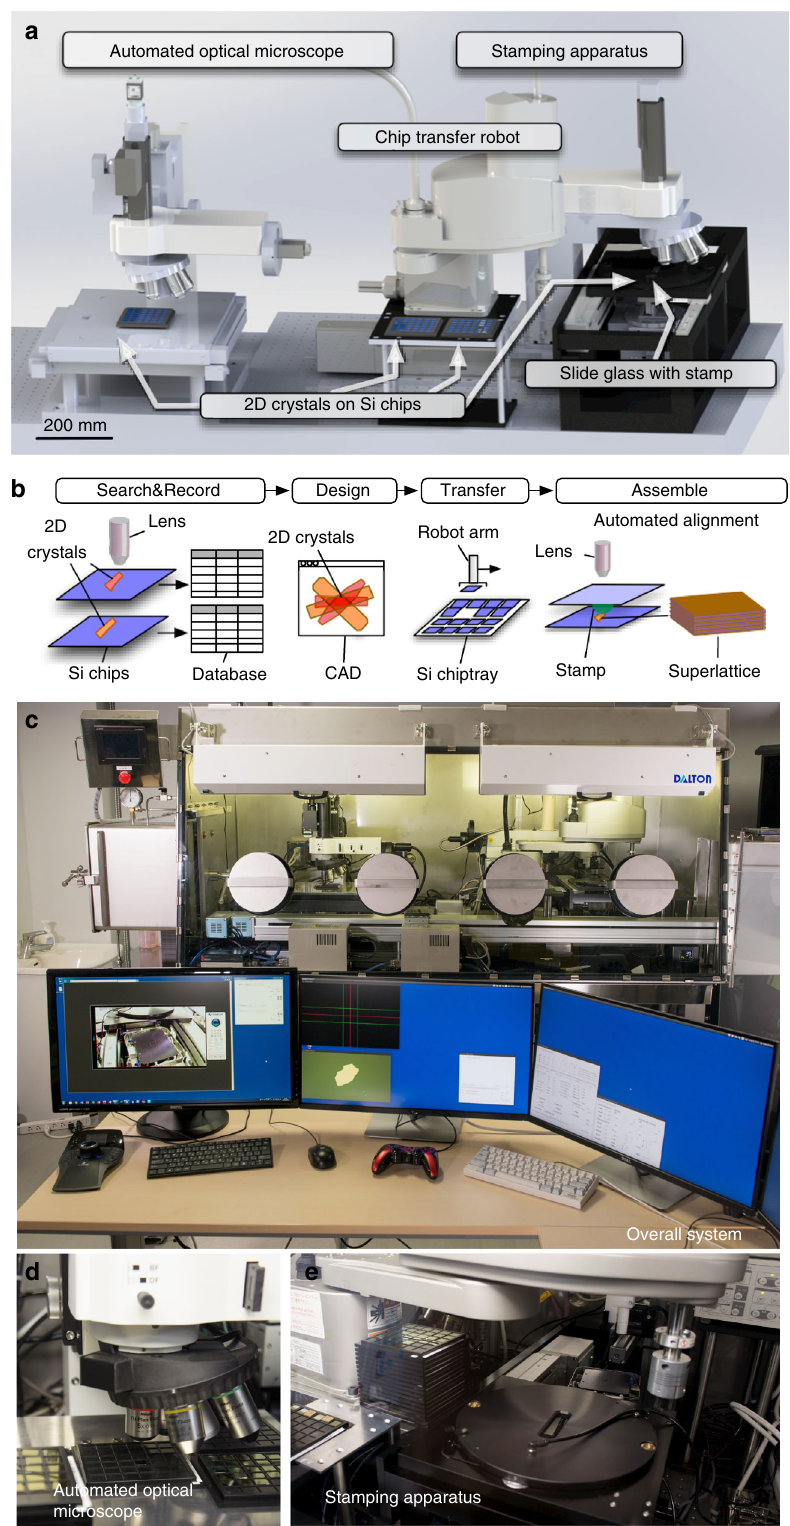
Fig. 1 The computer-assisted design schematics, functionalities, and photographs of the system. a Computer-assisted design schematics of the presented robotic system comprising an automated optical microscope, stamping apparatus, and Si chip transfer robot. b Schematics of the vdW heterostructure fabrication process. First, the automated high-speed optical microscope with motorized XY scanning stage scans the surfaces of SiO 2 /Si chips. When 2D crystals are detected, their positions and shape parameters are recorded in a database. By using customized CAD software, the combination, relative positions, and crystallographic orientations of the 2D crystals are designed. Finally, robots directed by the computer-vision algorithm assemble the vdW heterostructures layer by layer onto a polymer stamp through the vdW force. c – e Photographs of c entire system, d close up of automated optical microscope, and e stamping